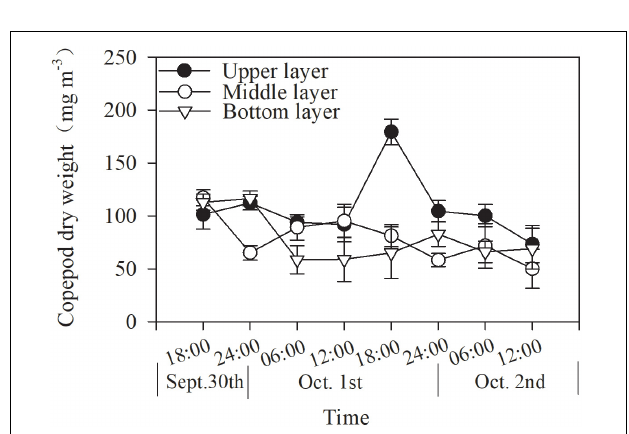
FIGURE 4 | Dial variation in copepod biomass in Daya Bay during September 30 to October 2,